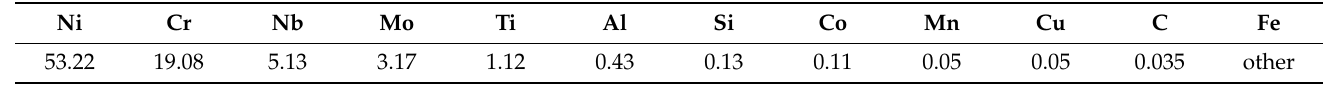
Figure 7. Strain rate in the depth direction of the workpiece surface.